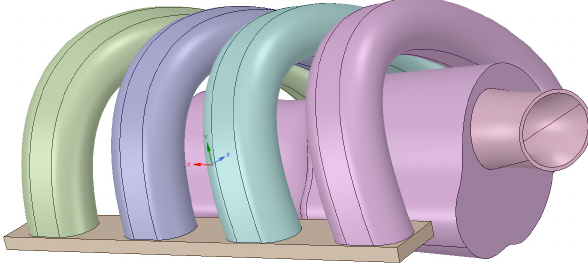
Fig. 3. CAD model for air intake system of Toyota corolla